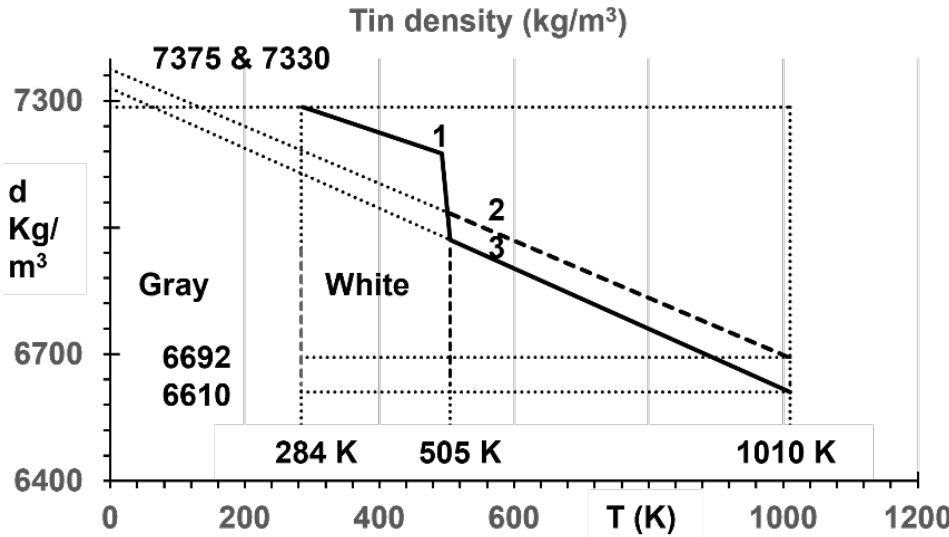
Figure 6. Tin density ( d ) in Kg/m 3 , versus T (K). Line (1) [60]; Line (2) [59]; Line (3) [63]. T x = 284 K, the glass formation temperature after undercooling and the melting temperature of gray tin. 2 T m = 1010 K.